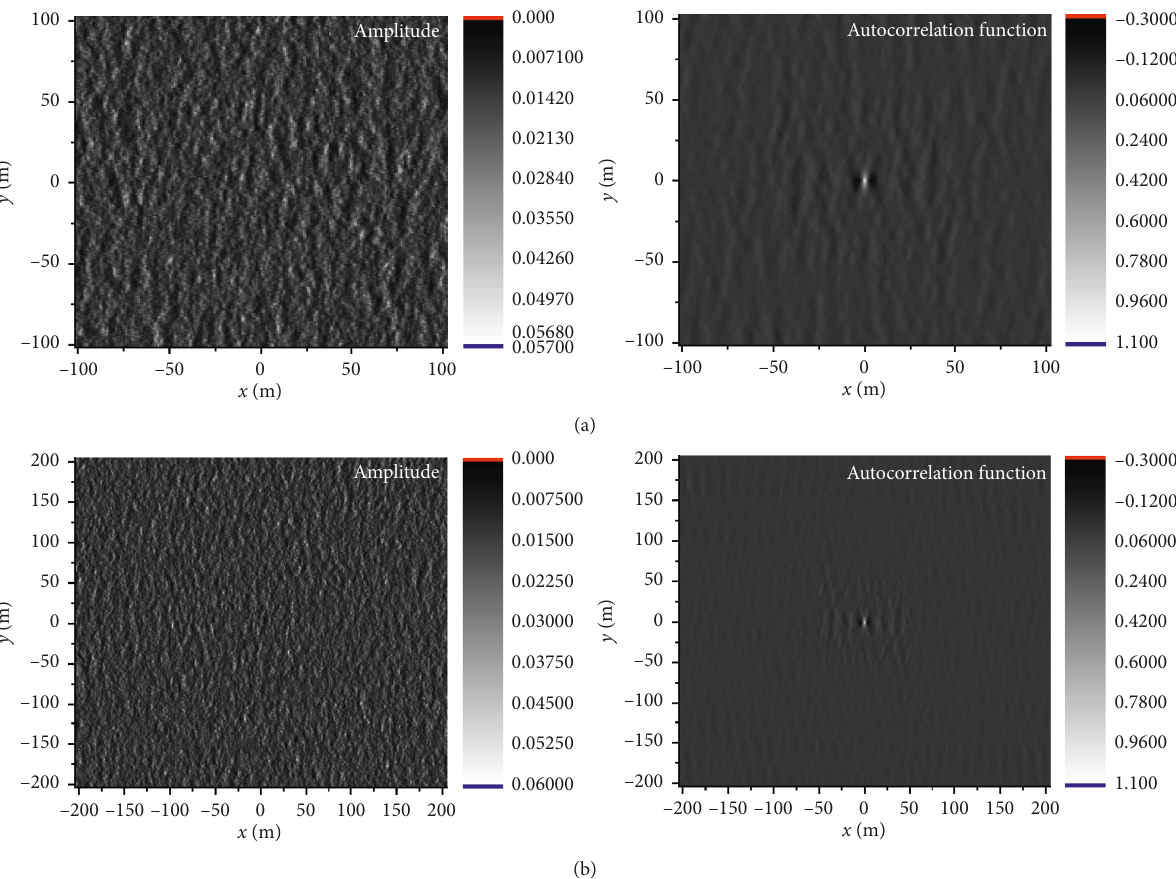
Figure 4: Comparisons of amplitude and autocorrelation function of 2D sea clutter by the statistical model with different sizes of scene. (a) 200m × 200 m. (b) 400m ×